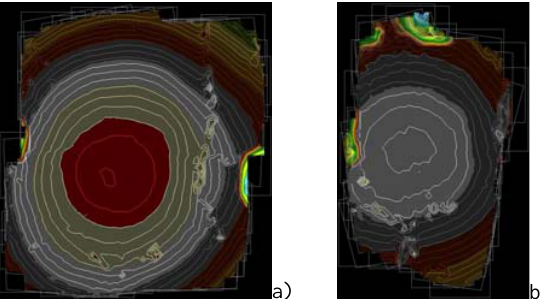
Figure 5: a) DSM of BezF1- b) DSM of BezF6. The “dome” in the center is erroneous. Contour interval 2.5m.